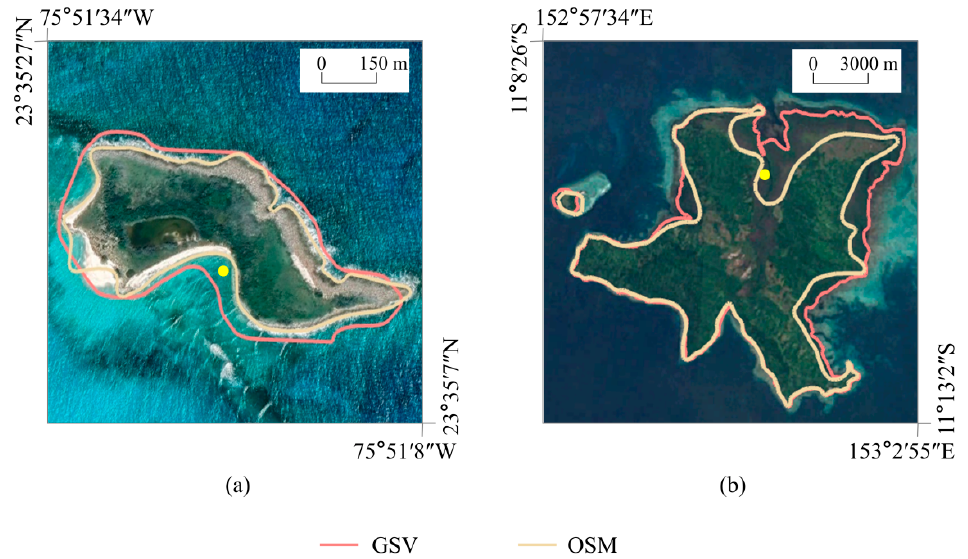
Figure 5. Illustrating the performances of two island datasets (GSV and OSM) by overlapping them with satellite images ( a , b ) in Google Earth.